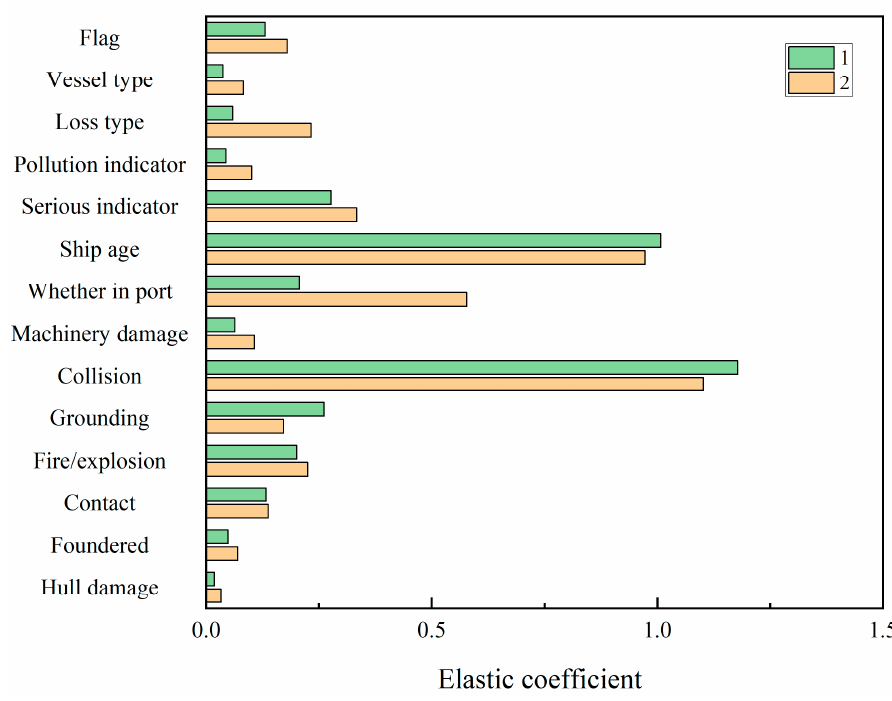
Figure 4. Absolute values of elasticity coefficients of the zero-inflated negative binomial models represented by a bar chart.